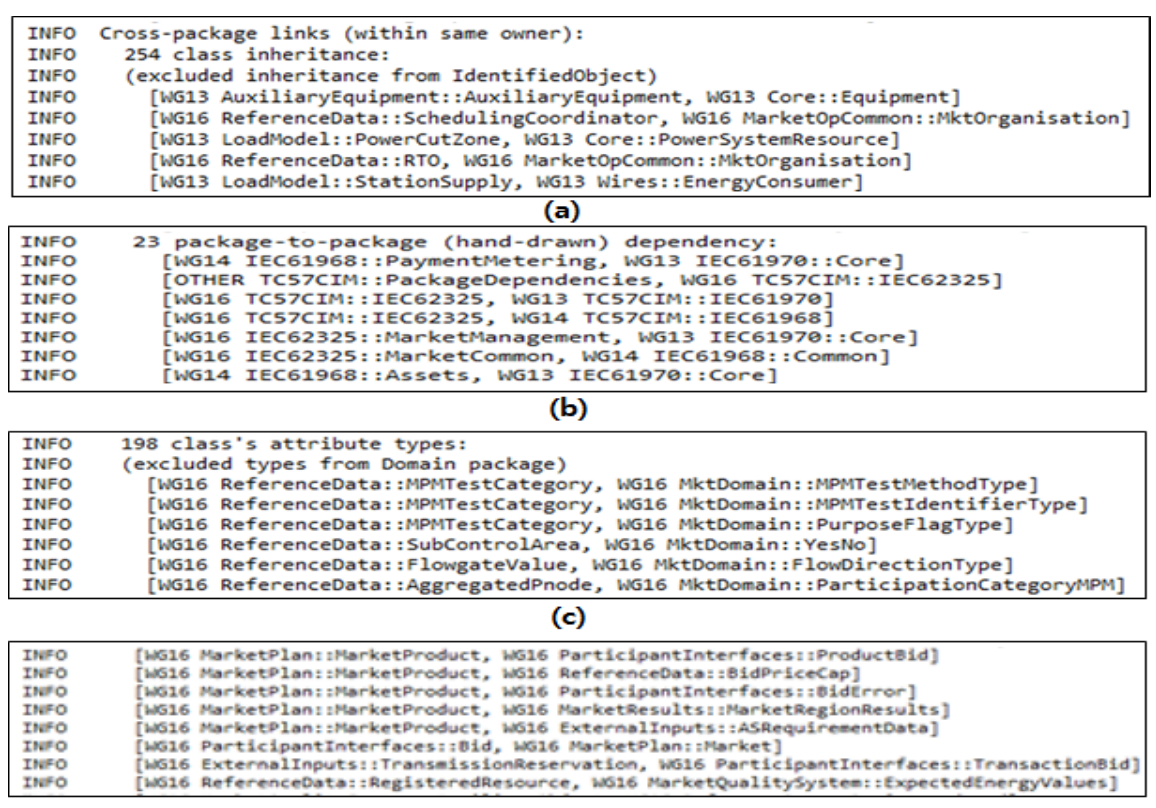
20 Table 6. Optimal CMP Specifications with KVM Hypervisor. # of VMGs